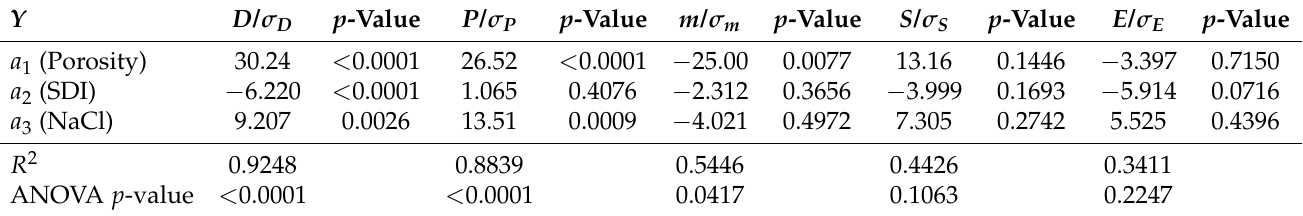
Table 3. Coefficients from multiple regression analysis. Non-significant coefficients at 95% confidence interval ( p > 0.05) are shaded. The coefficients accepted at 90% confidence interval (0.10 > p > 0.05) are in lighter